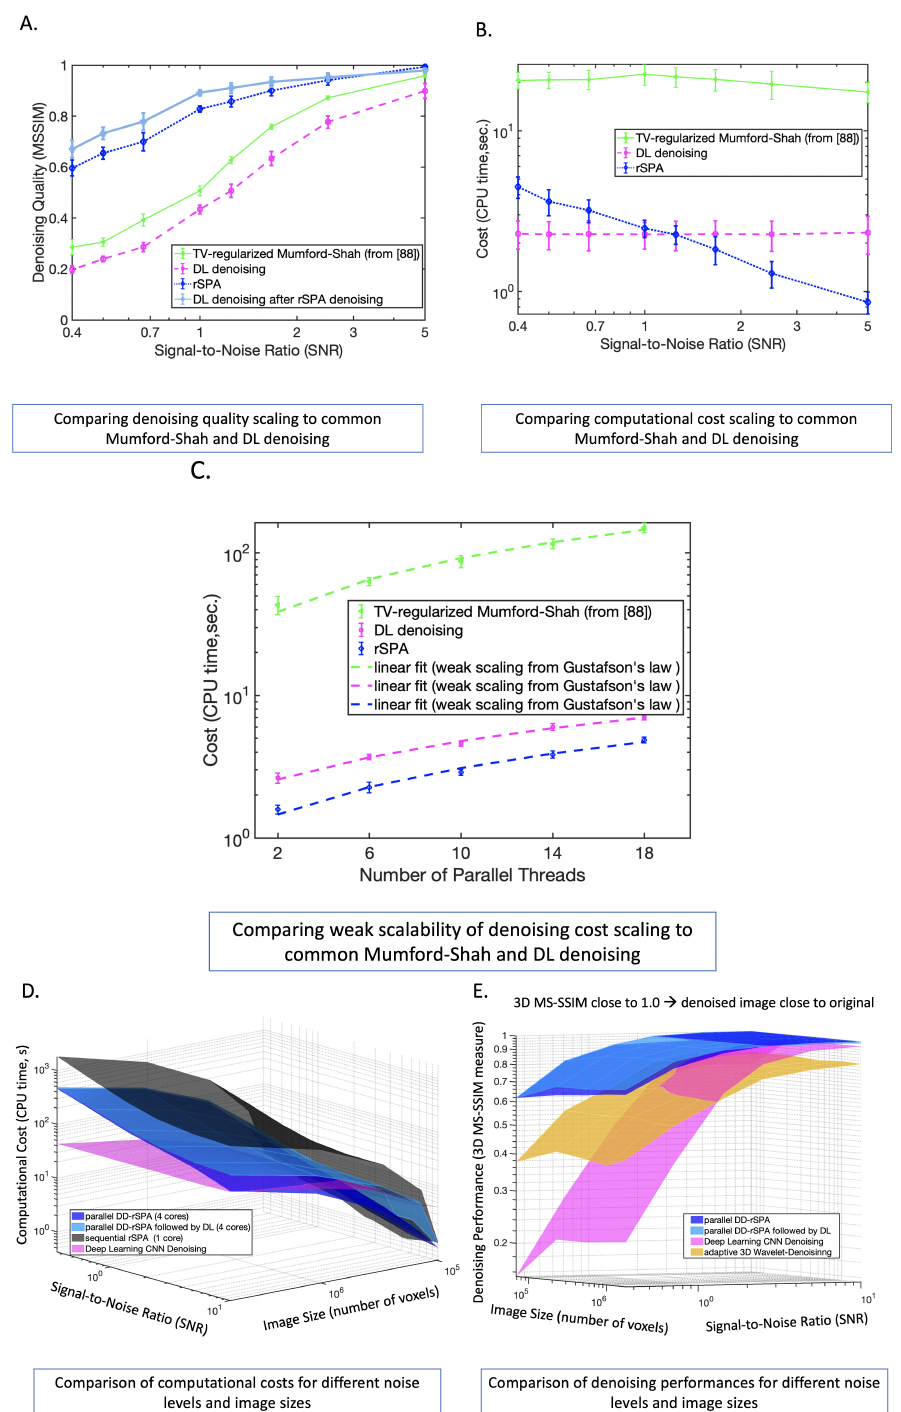
Figure 5. Comparing denoising quality, cost and parallelizability: ( A – C ) comparison of PMS rSPA algorithm to the regularized Mumford–Shah denoising tool introduced in [93] and to the additionally trained DL denoising algorithm from Figures 3 and 4; ( D , E ) computational cost scaling and perfor- mance for DL (without taking into account time for additional training), sequential rSPA, parallel DD-rSPA and DD-rSPA followed by DL. Each point of each method’s curve and surface is obtained from statistical averaging of the respective values obtained by analyzing 10 randomly-generated images with these particular combinations of image size and noise